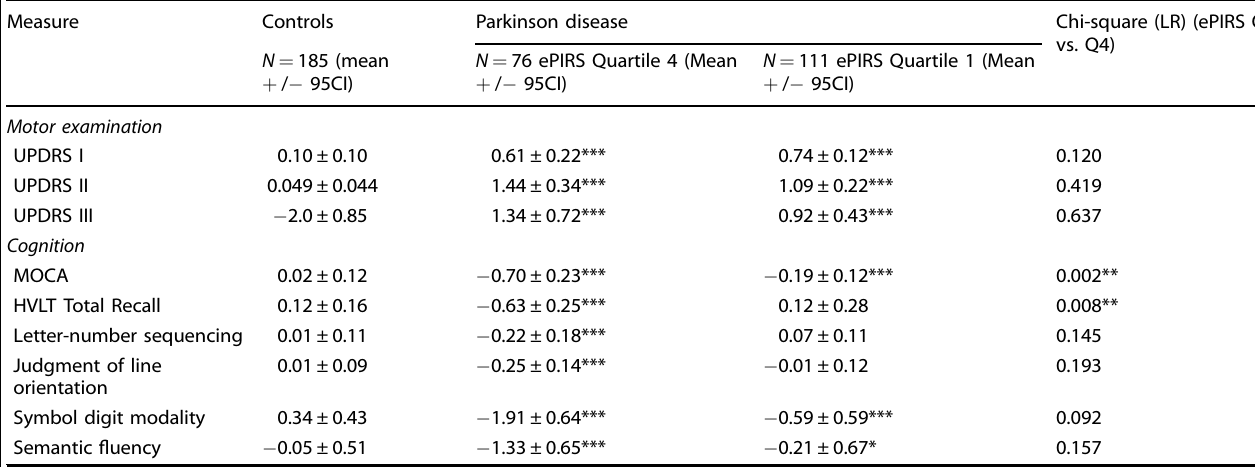
Table 4. Change in motor, neurobehavioral, and cognitive function, slope (mean point change per year), with 95% con fi dence intervals, for motor and cognitive scores in PPMI for all de-novo subjects with at least 5 years of data available.